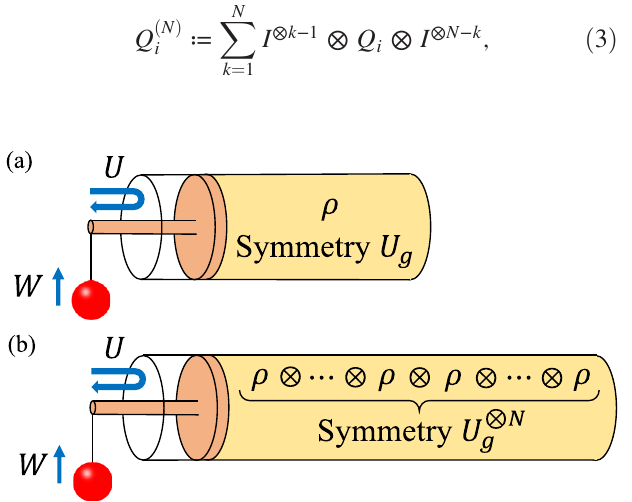
FIG. 2. Schematics of passivity and complete passivity under symmetry constraints. The work W is extracted by the unitary operation U . (a) A state ρ is called symmetry-protected passive if one cannot extract positive work from a single state by any symmetry-respecting unitary U , which commutes with all U